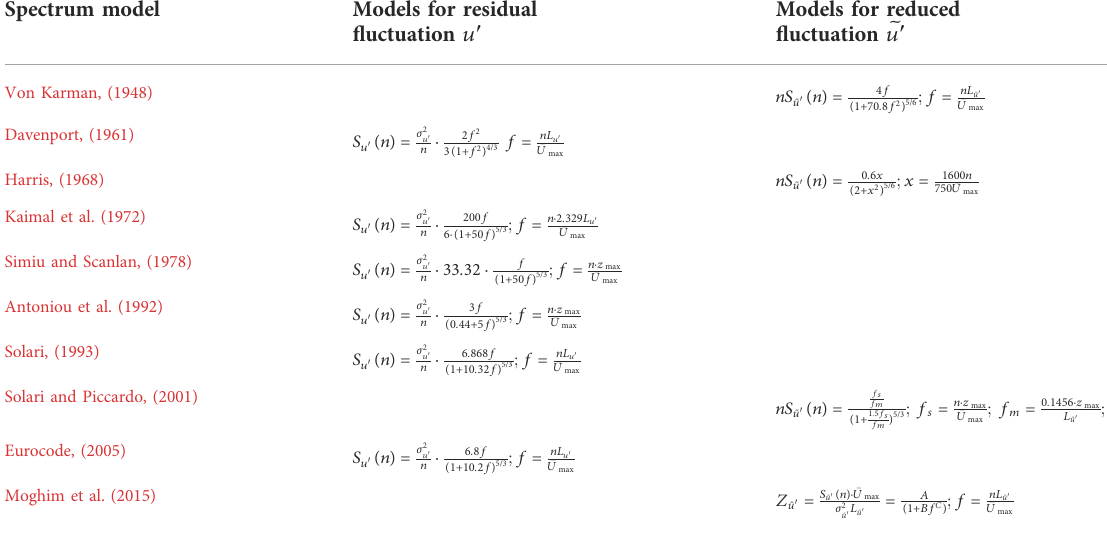
TABLE 3 Available power spectral density models in literature. Spectrum